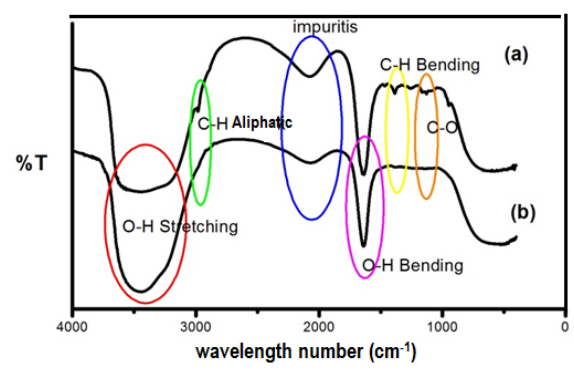
Figure 11: FTIR spectrum of isopropanol at before (a) and after photo degradation with ZnS-TiO /C-fiber as a catalyst. 2